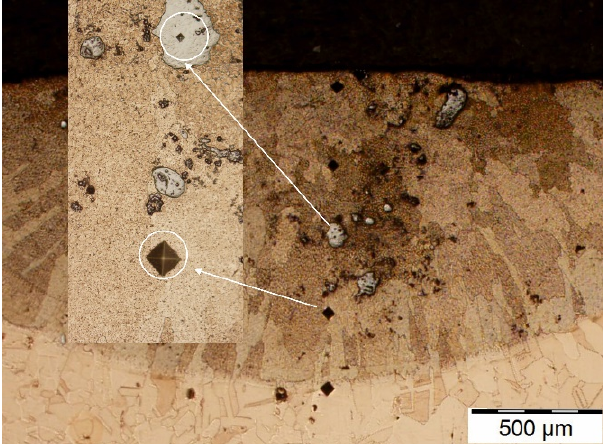
Figure 16. The cross-sectional microhardness of LSA Cr75WC25 samples.